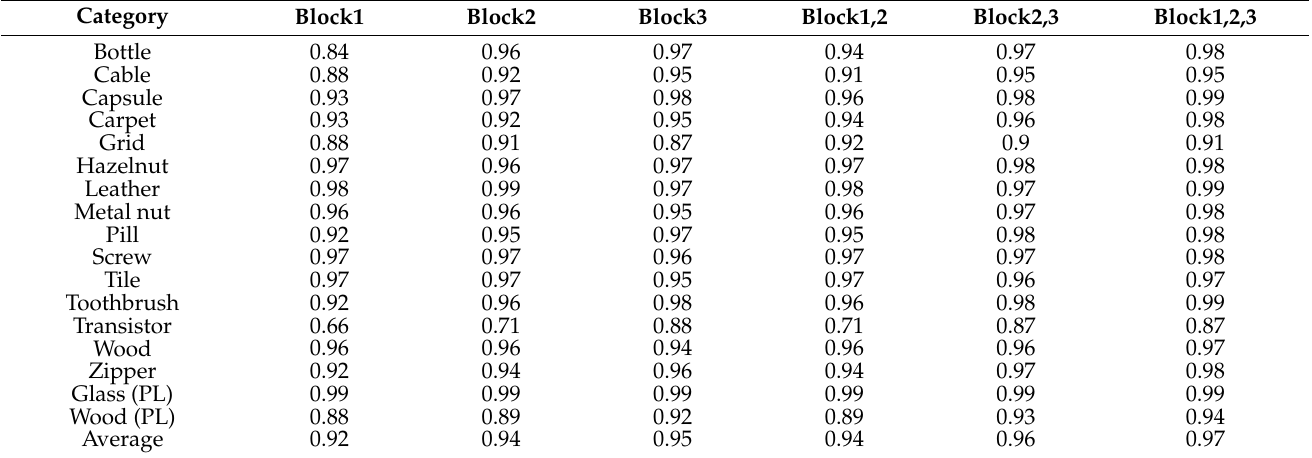
Figure 5. Average AUCs of all categories with: ( a ) different pre-trained feature extractor; ( b ) different blocks of ResNeXt101 feature extractor. Table 6. AUCs of proposed method with different feature extractor